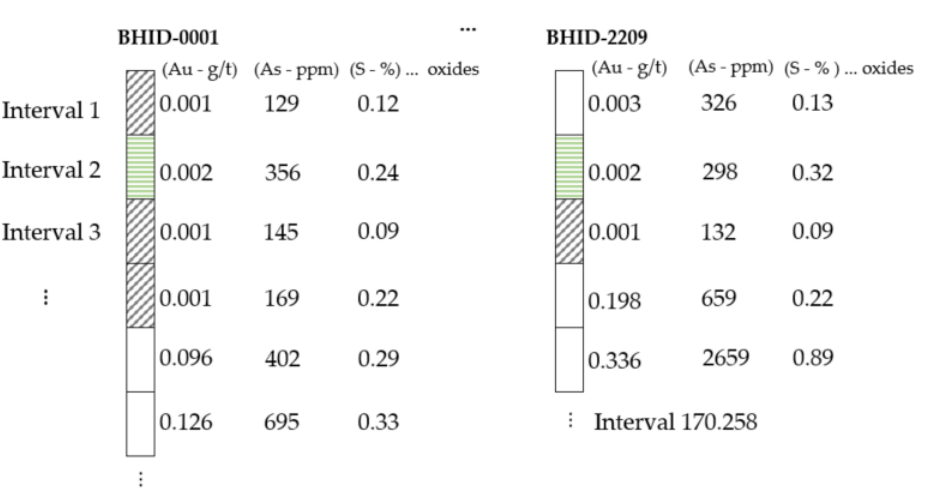
Figure 1 indicates, per gold content (e.g., 0.001 g/t of gold content), the average of the chemical element calculated. Gold content (e.g., 0.001 g/t content) can occur frequently in several holes. Equation (3) represents the calculation.